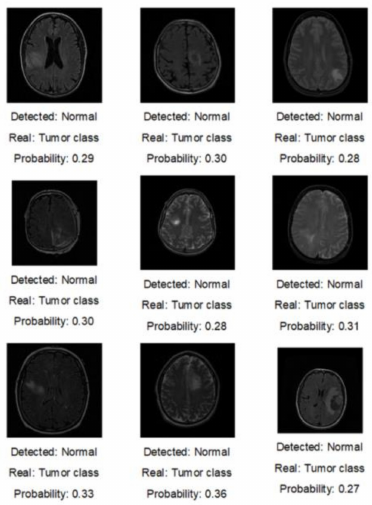
Figure 6. Classification results attained with customized VGG19 with SVMRBF.